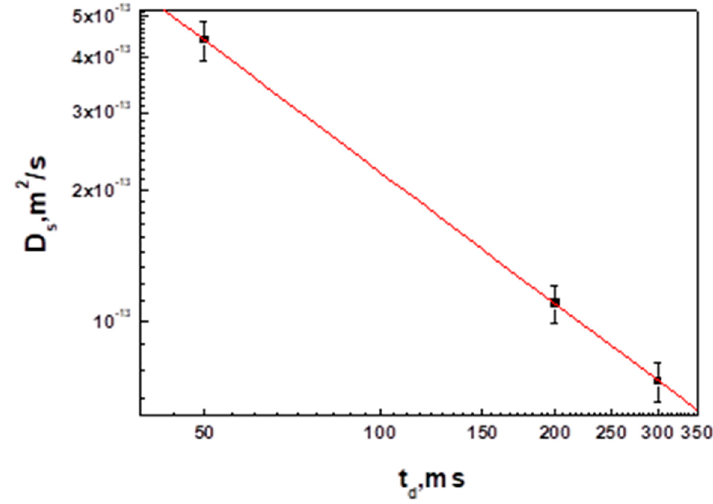
Figure 5. Dependence of the self-diffusion coefficient of HA species D s on diffusion time t d . The solid line represents a slope of t − 1 and shows that experimental values of D s are inversely proportional to t d . d The experimentally obtained dependence of the minimum SDC ( D time t d for a sample of water solution of hyaluronic acid 0.75% (wt.) in the presence